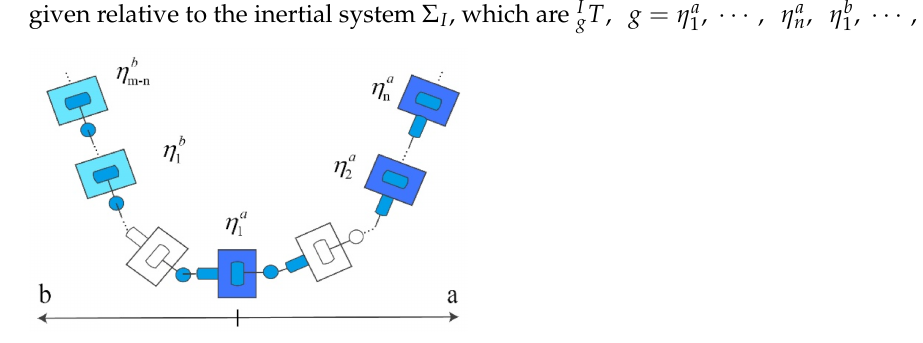
Figure 2. Schematic diagram of task module on both sides of the base coordinate